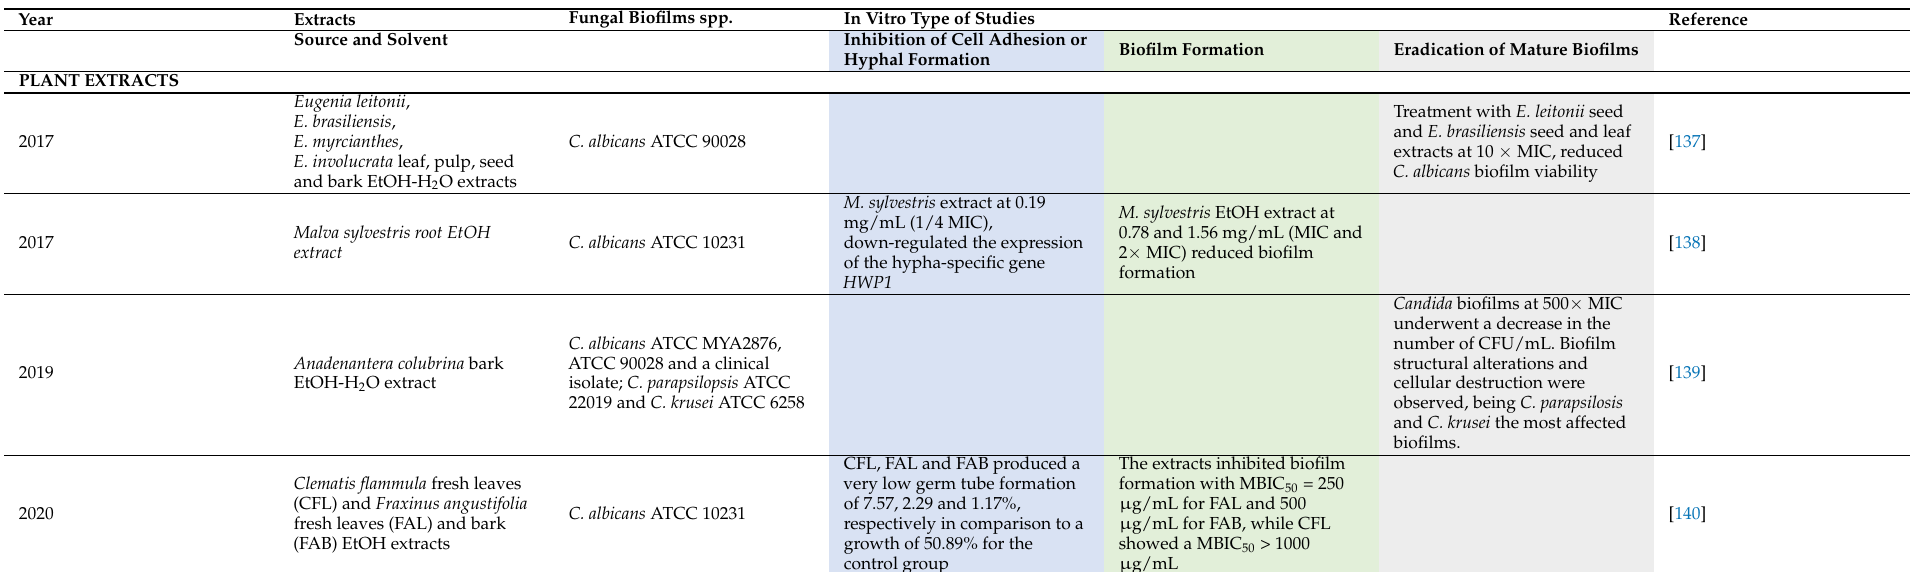
Table 3. More relevant results of extracts from plants, algae and cyanobacteria showing a capacity for inhibiting fungal